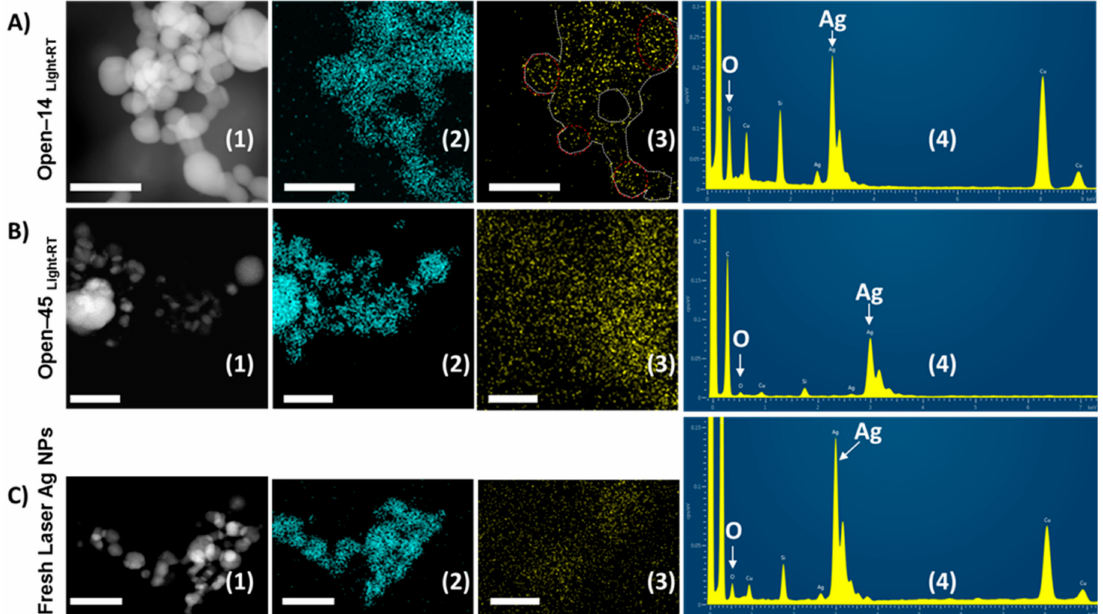
Figure 5. Elemental maps using scanning transmission electron microscopy (STEM)-X-ray energy dispersive (EDX) spectroscopy analysis for AgNPs. The laser generated AgNPs were stored under daylight condition at room temperature but subjected to the air exposure every 14 days (the Open-14 Light/RT sample, ( A1 – A4 ), or every 45 days (the Open-45 Light/RT sample, ( B1 – B4 ), in which: ( A1 – C1 ) STEM-high-angle annular dark-field detector (HAADF) images showing AgNPs, ( A2 – C2 ) Ag maps obtained from HAADF regions, (A 3 – C3 ) O maps obtained from HAADF regions; and ( A4 – C4 ) EDX spectra integrated from HAADF image regions. Fresh prepared laser AgNPs were presented in ( C1 – C4 ). All scale bars are 100 nm. The trace line on ( A3 ) was manually produced to highlight the shape of oxygen